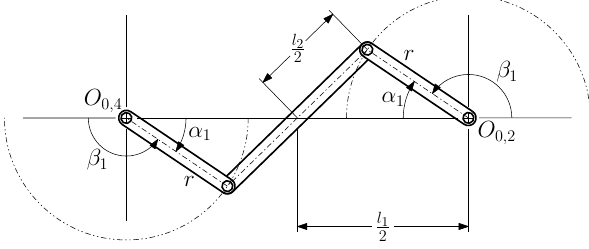
Figure 8. Linkage between the index finger and ring finger if the middle positions occur